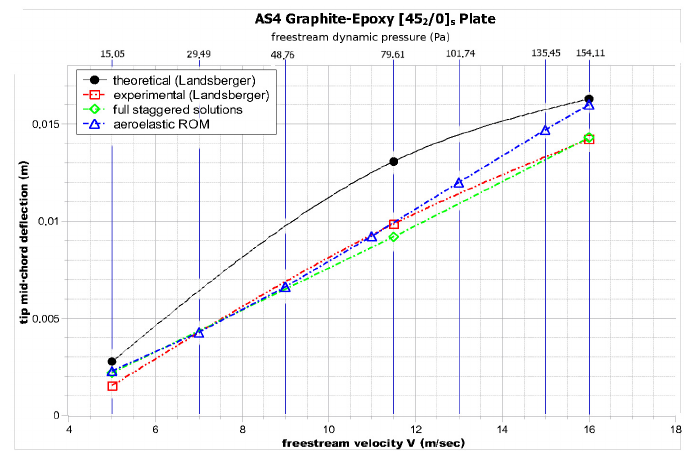
Figure 8. Tip mid-chord static aeroelastic deflection for the [ 45 2 /0 ] s plate wing.